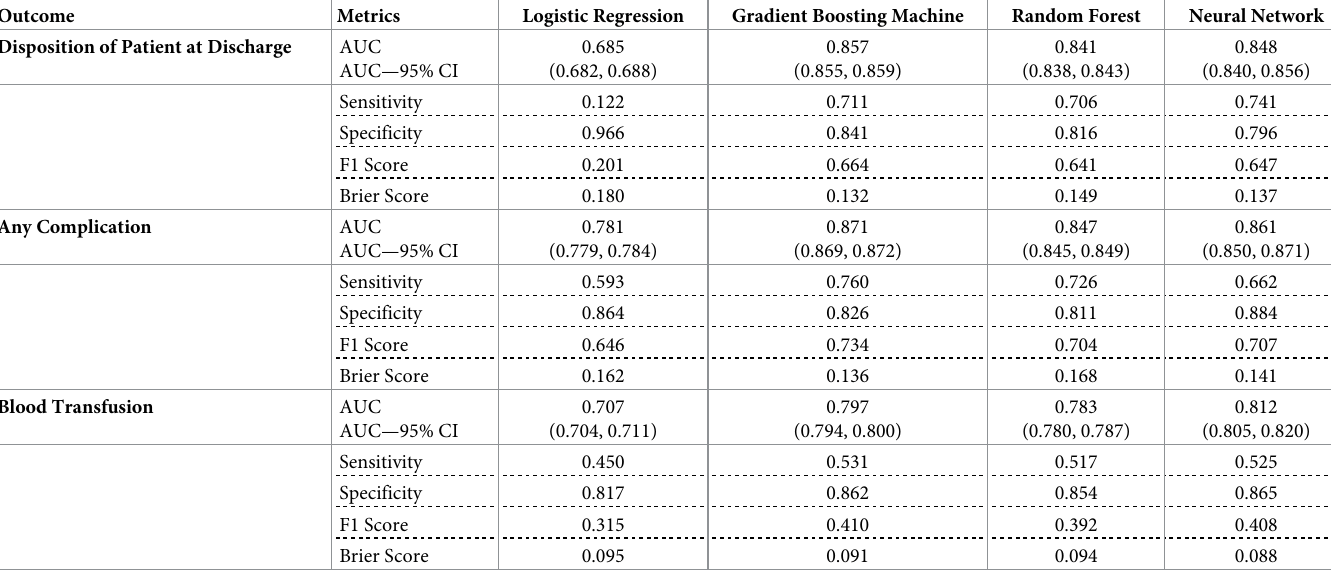
Table 2. Comparison of predictive model performance on test data using logistic regression and machine learning methods.